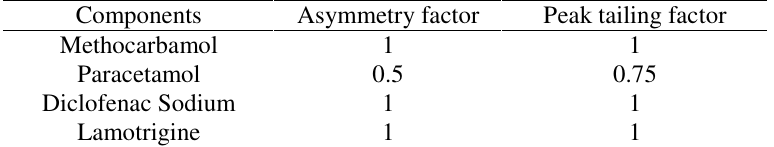
Table 5. Asymmetry factor and peak tailing